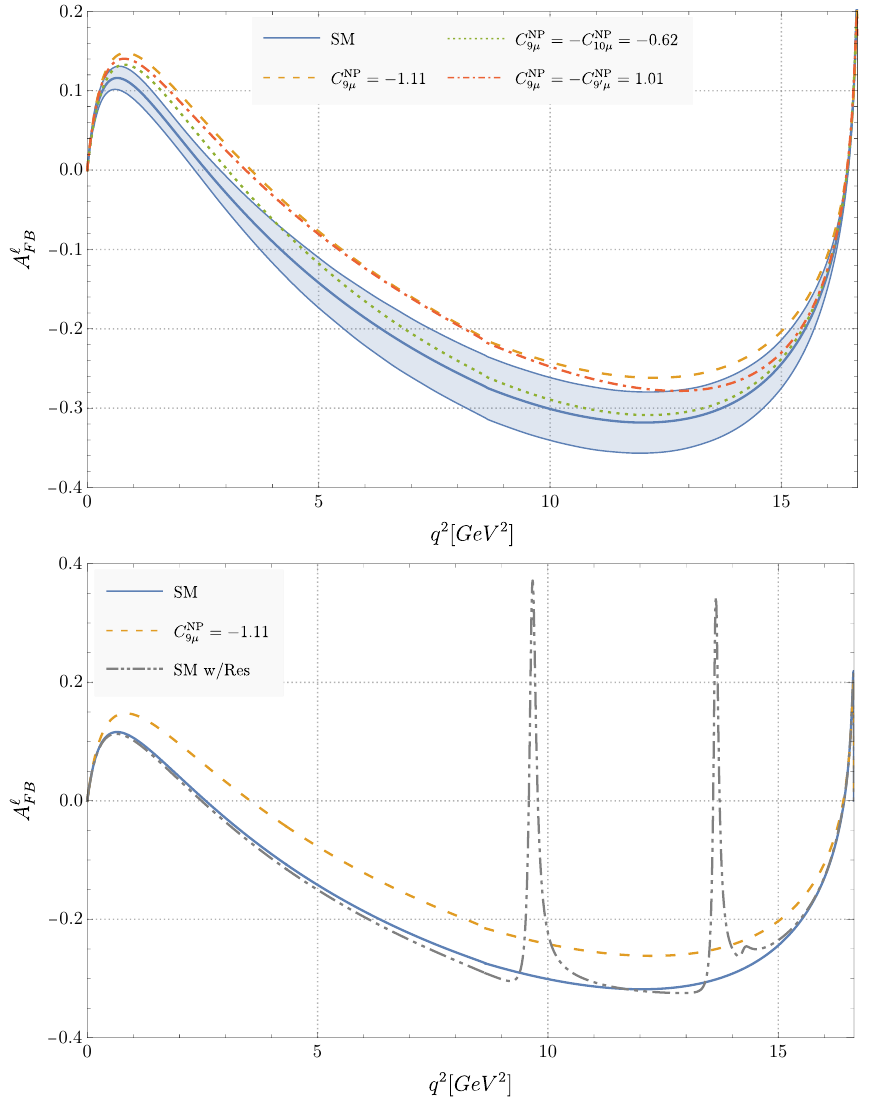
Figure 3 . Top: A ‘ in the SM case and three NP scenarios. Only short-distance contributions FB from charm loops are include. Bottom: For illustration only, we also show the e(cid:11)ect of a model for charmonium resonances in the SM case